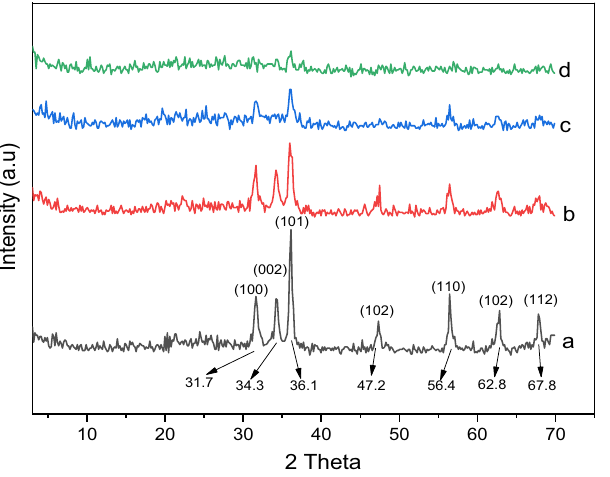
Figure 2. XRD pattern for ( a ) ZnO, ( b ) ZnO/5PVA, ( c ) ZnO/7PVA and ( d ) ZnO/10PVA calcined at 400 °C.